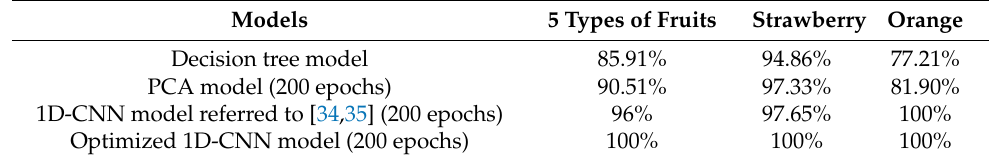
Table 1. Five-fold cross-validation recognition accuracy with different models.